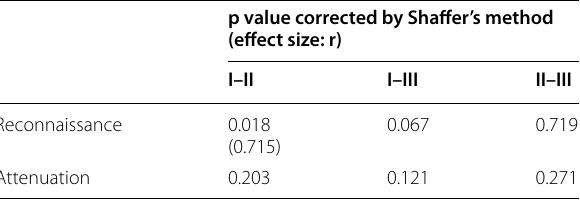
Table 13 p-values based on a comparison for each type p value corrected by Shaffer’s method (effect size: r)